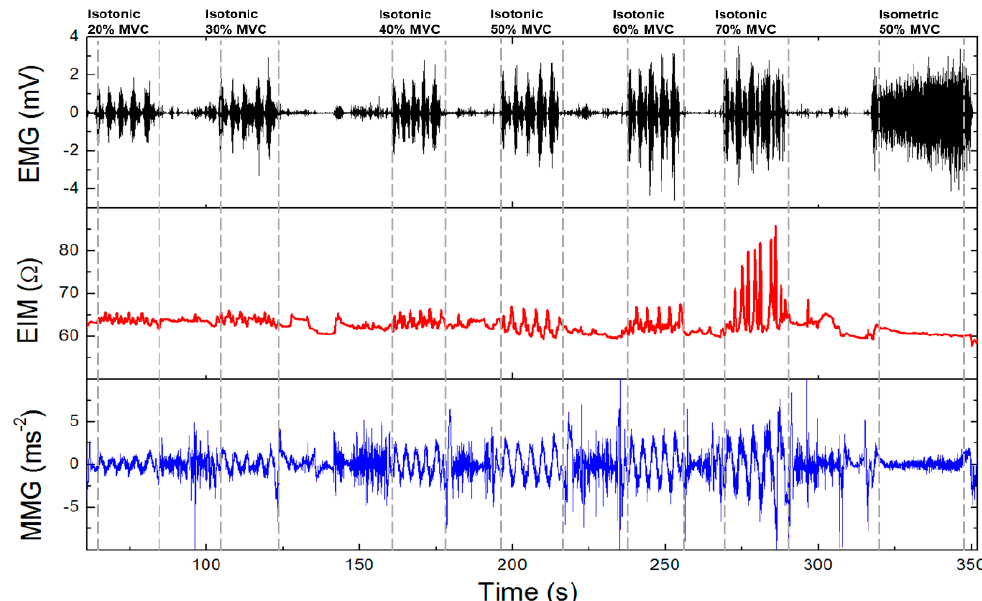
Figure 5. Electromyography (EMG)/electrical impedance myography (EIM)/mechanomyography (MMG) signal of one volunteer.